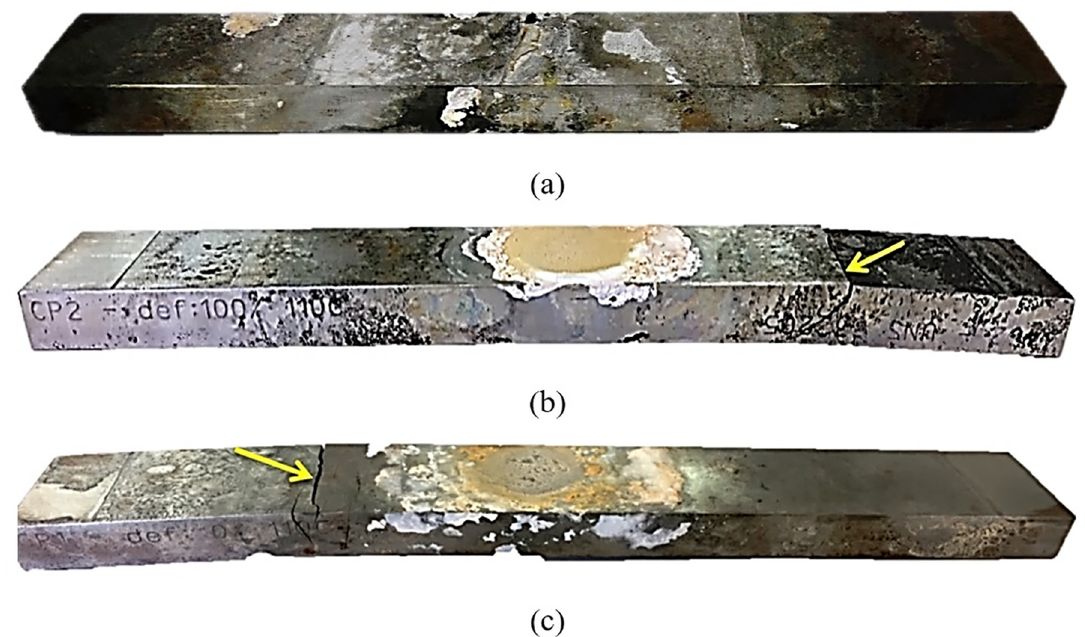
Figure 8. Visual inspections of specimens tested at 110 ºC for 500 hours after the cleaning. (a) UNS S31603 ASS tested at 50 % of the yield stress (139 MPa); (b) UNS S32205 DSS tested at 100 % of the yield stress (473 MPa); and (c) UNS S32750 SDSS tested at 100 % of the yield stress (589 MPa). Visual inspection.